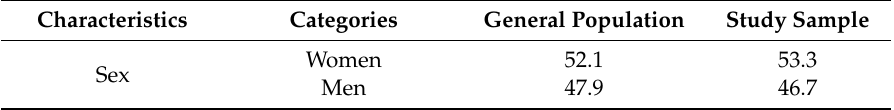
Table A1. A comparison of the sample with the general population